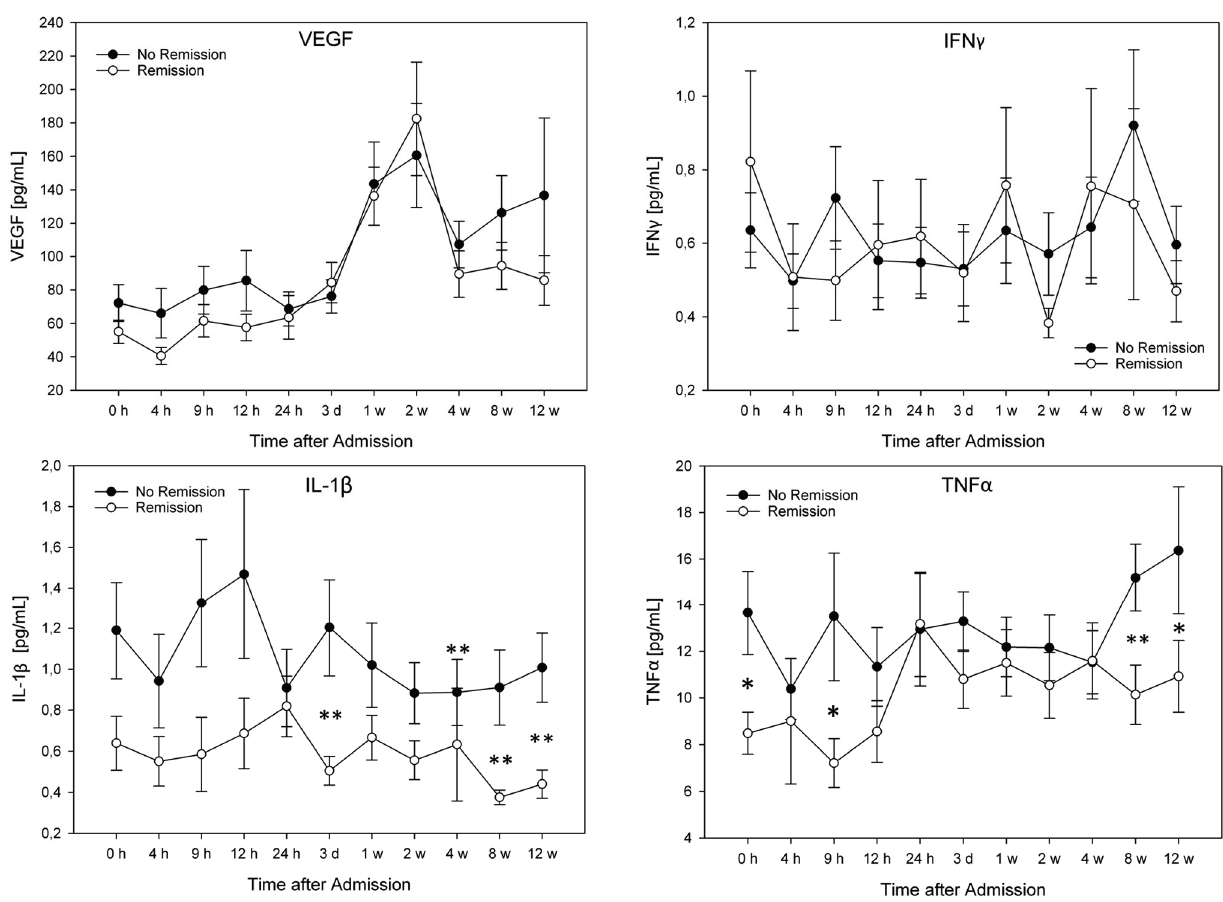
Figure 1. Serum levels of all traumatic SCI patients 12 weeks after admission, expressed as means ± standard error of the mean. The Wilcoxon signed-rank test assessed significant differences from the admission level (0 h) in each group, * p < 0.05, ** p < 0.01. Abbreviations: h = hours; d = day; w =